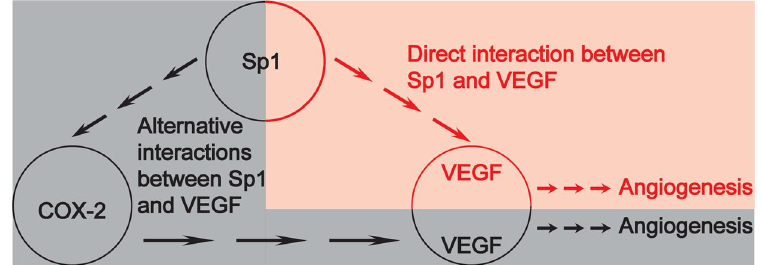
Figure 7. The complex signalling cascades between Sp1 and VEGF in PDAC. It has been reported previously that Sp1 can transcriptionally activate VEGF expression (shown in red). Our study shows that Sp1 can also promote VEGF expression via the upregulation of COX-2 expression (shown in